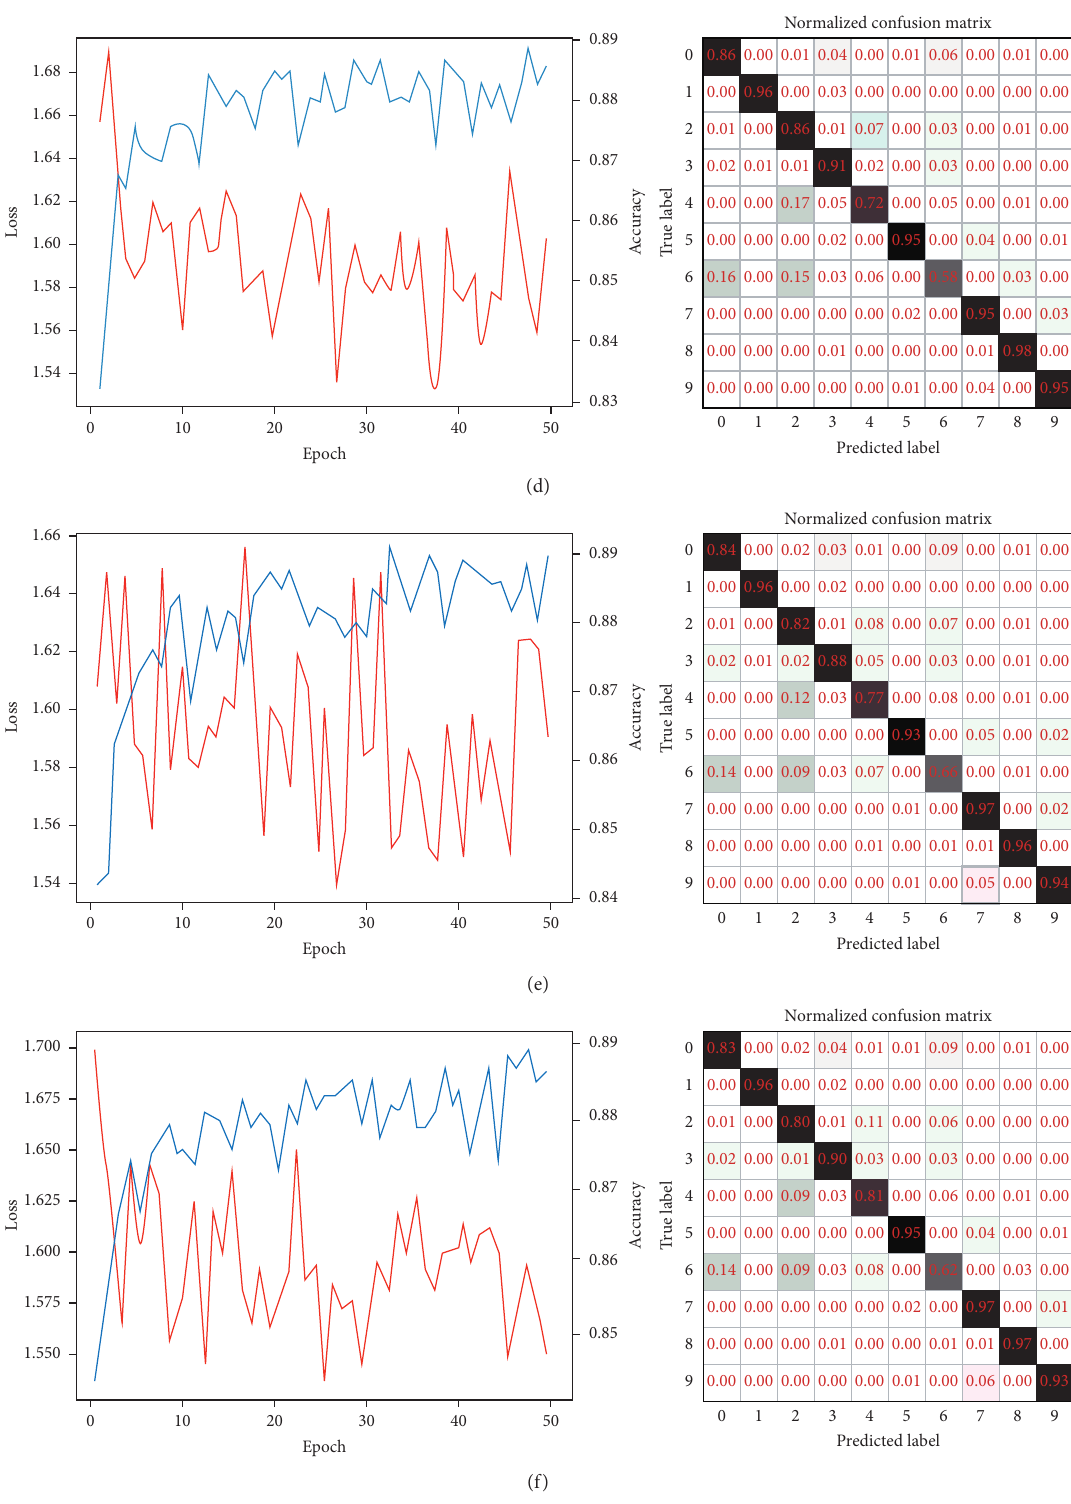
Figure 9: (a) Accuracy rate and confusion matrix of the MNISTdataset by the neural network with the Leaky-ReLU function. (b) Accuracy rate and confusion matrix of the MNIST dataset by the PReLU function neural network. (c) Accuracy rate and confusion matrix of the MNISTdataset by the RReLU function neural network. (d) Accuracy rate and confusion matrix of the Fashion-MNISTdataset by the neural network with the Leaky-ReLU function. (e) Accuracy rate and confusion matrix of the Fashion-MNIST dataset by the PReLU function neural network. (f) Accuracy rate and confusion matrix of the Fashion-MNIST dataset by the RReLU function neural